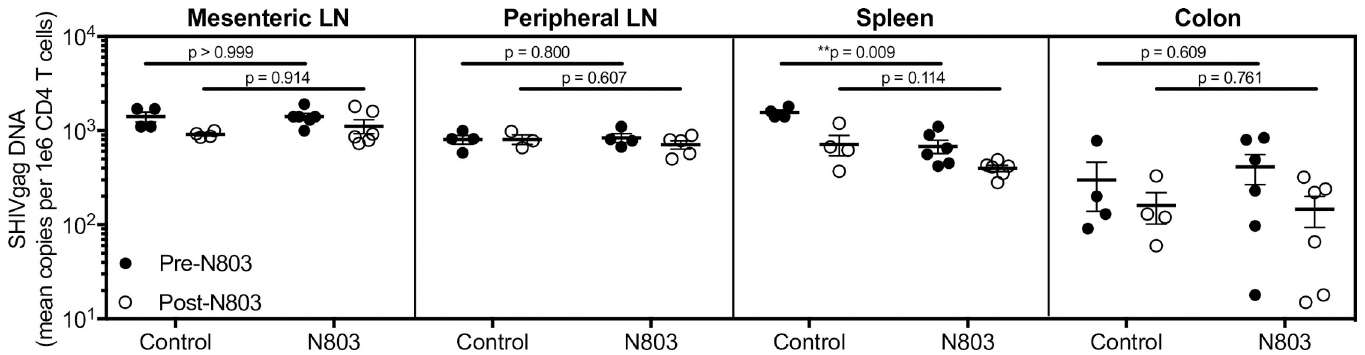
Fig 9. N-803 treatment does not perturb the viral reservoir. Cell-associated SHIV DNA from CD4-sorted, single-cell suspensions of tissues (mesenteric lymph nodes, peripheral lymph nodes, spleen, and colon) before N-803 and after all 4 injections of N-803. Data shown are means ( ± SEM). P values were calculated using a Mann- Whitney test. � , P < 0.05; �� , P < 0.01; ��� , P < 0.001.